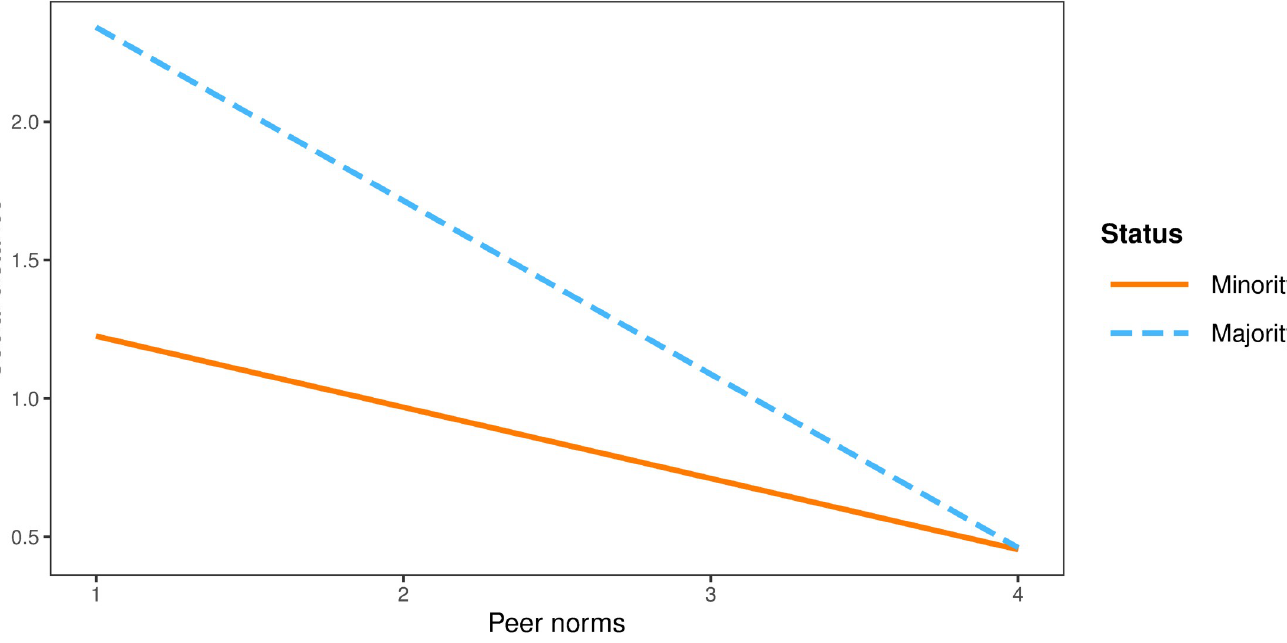
Fig 4. Interaction plot between peer norms and group status on social